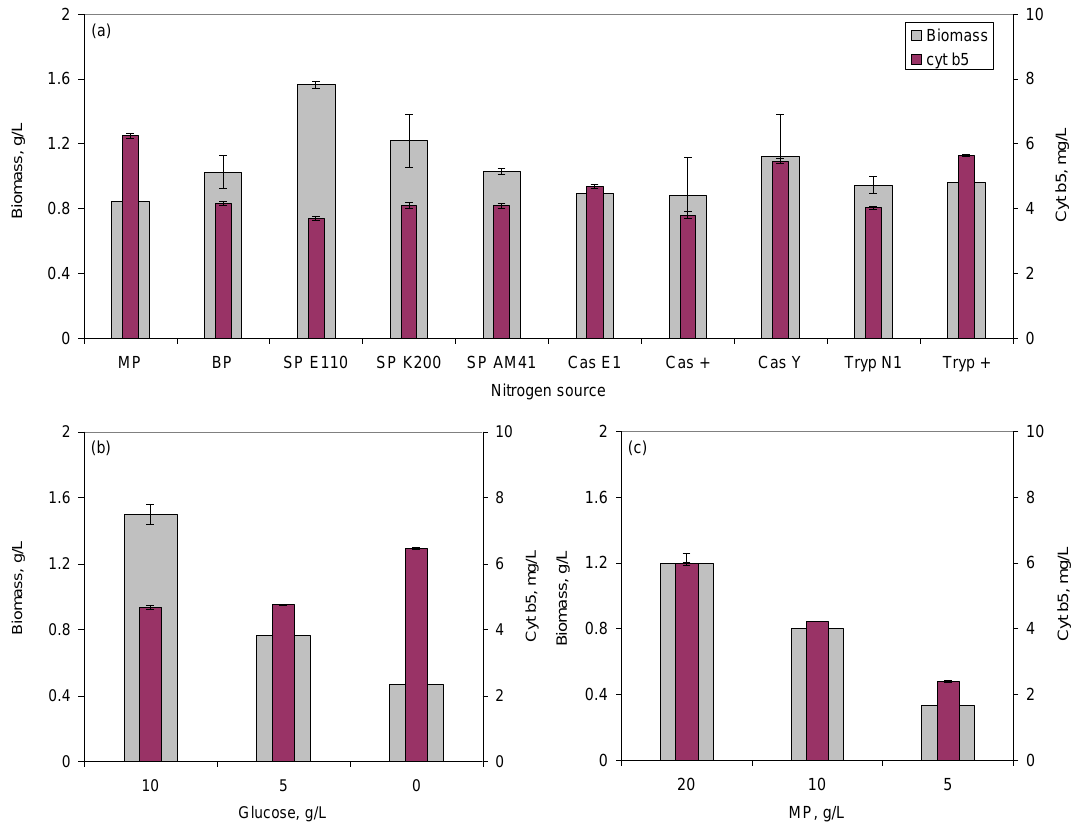
Figure 1. Biomass and cytochrome b5 production according to the nitrogen source ( a ), and to the initial glucose ( b ) and meat peptone ( c ) concentrations used.